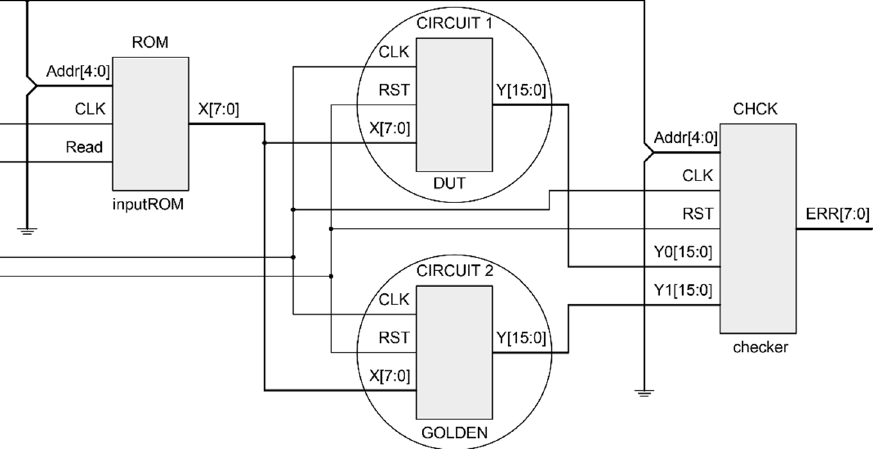
Figure 7. Design for the experimental setup.